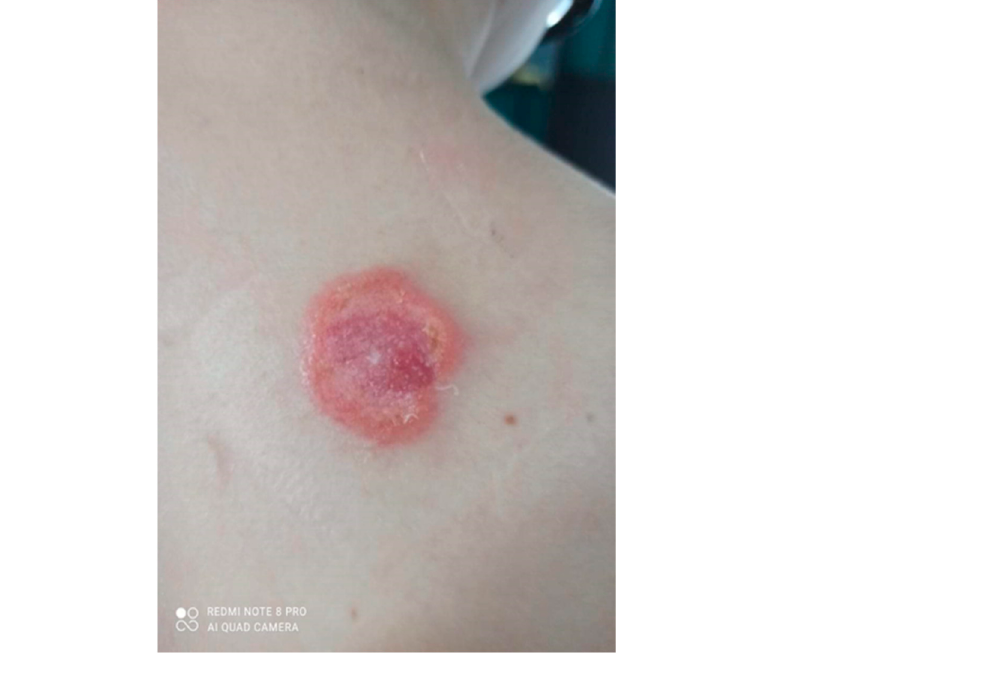
Figure 2. Gradually growing lesion with a thickened lump, the beginning of disintegration of the central papule.